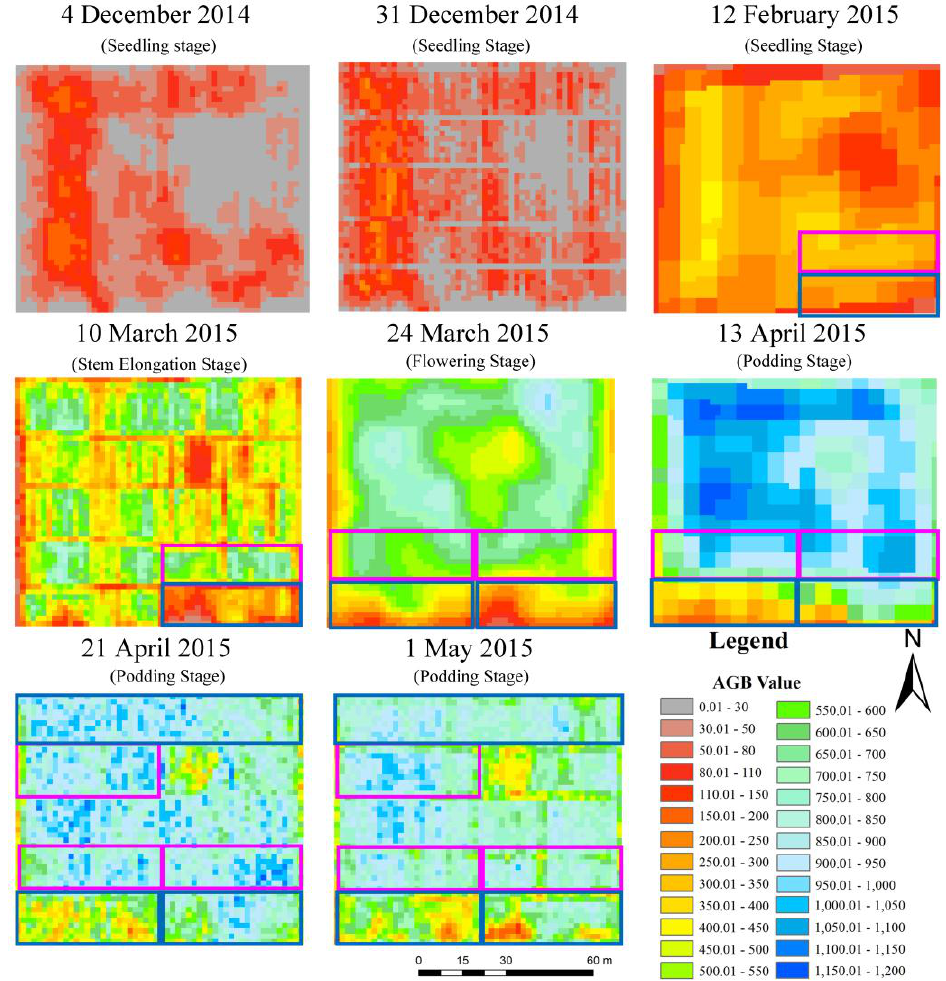
Figure 5. Maps of winter oilseed rape AGB during the vegetative growth stages from 2014 to 2015. The blue rectangles and red rectangles represent the plots were conducting, or had finished with, the flooding and waterlogging treatment, respectively.